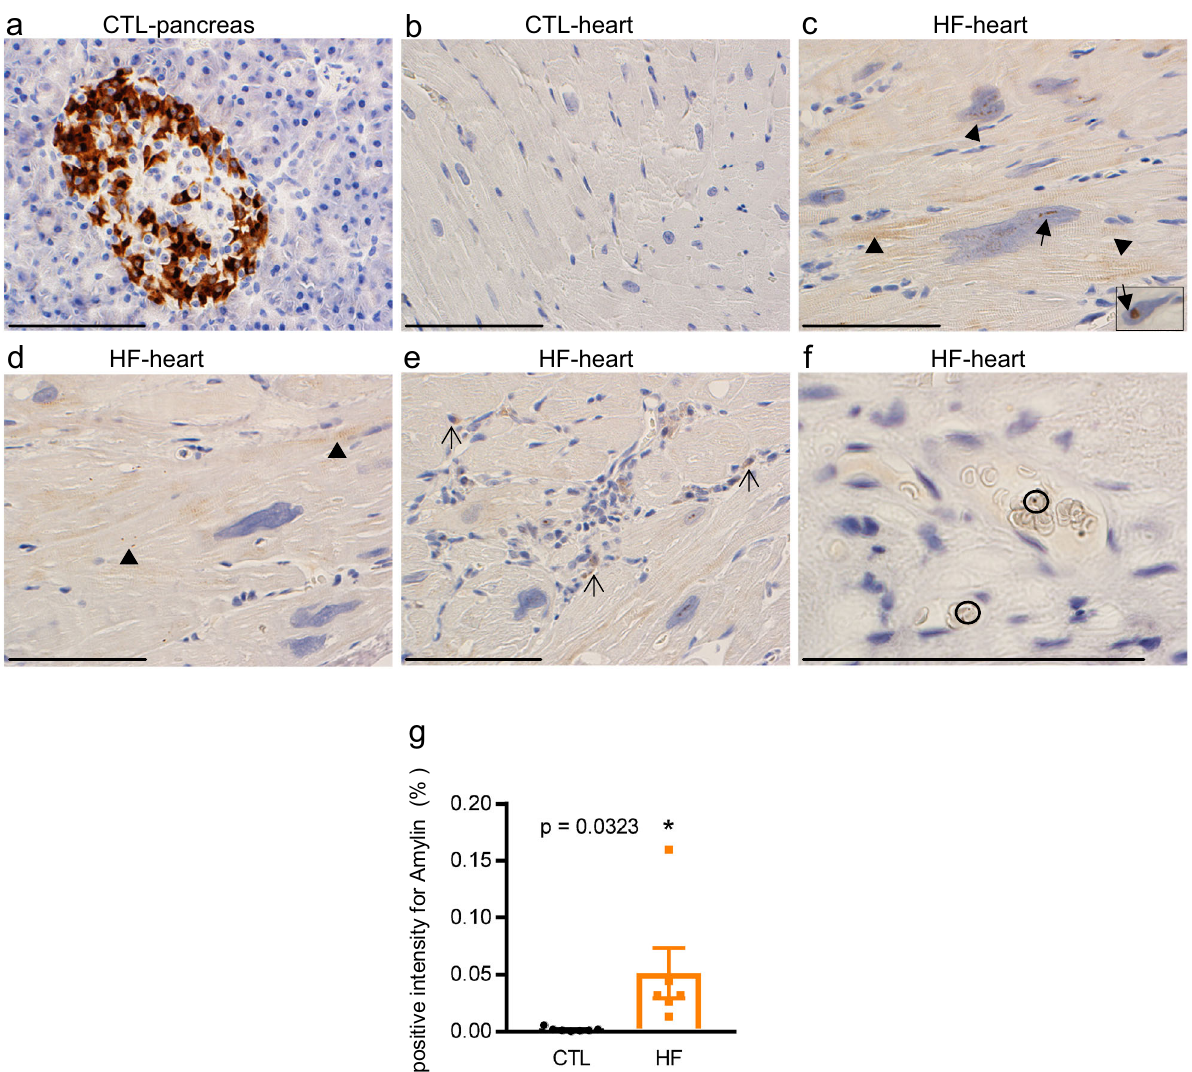
Fig. 2 Amylin deposition in the heart sections of NHPs with HF. a – f Amylin staining visualized with DAB chromogen. a Positive staining for amylin in pancreas from CTL NHPs. b No amylin deposits were observed in the CTL heart ( n = 7). c – f Amylin deposition in the nucleus ( c ), hypertrophic cardiomyocyte sarcolemma ( c and d ), in fl ammatory cells ( e ), and blood cells ( f ) of the HF group ( n = 6). g Bar graph presented the relative positive signal intensity for amylin in a 284 × 214 μ m fi eld of view of heart sections from NHPs with CTL ( n = 7) and HF ( n = 6). Scale bar, 100 µ m. Data represent mean ± SEM, * P < 0.05 by student ’ s t